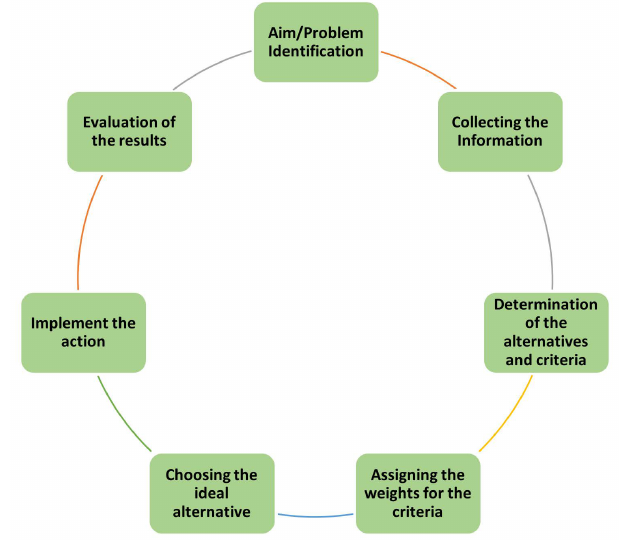
Figure 2. The process of the decision-making